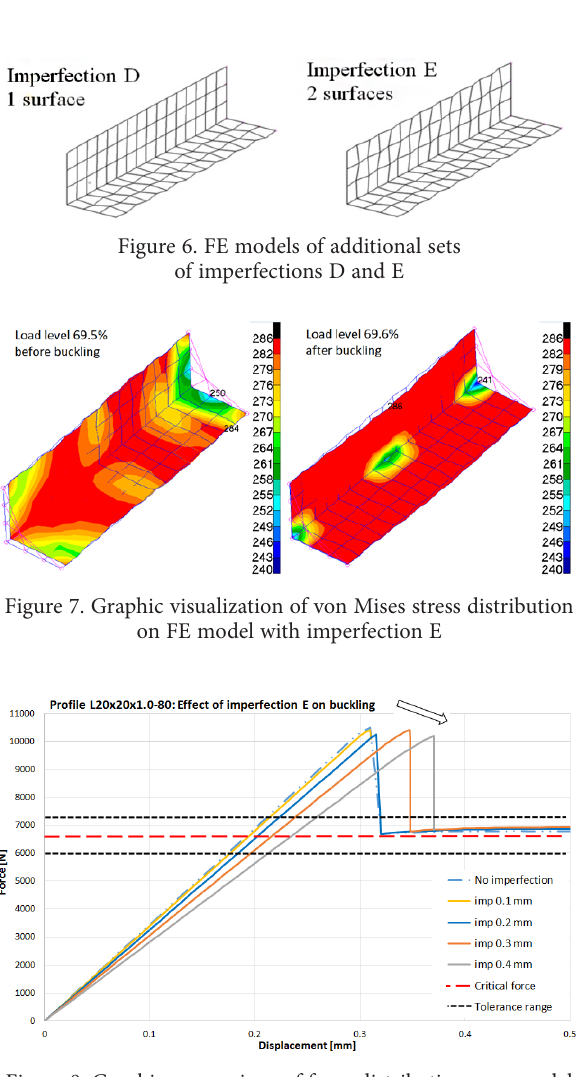
Figure 8. Graphic comparison of force distributions per model displacement for imperfection